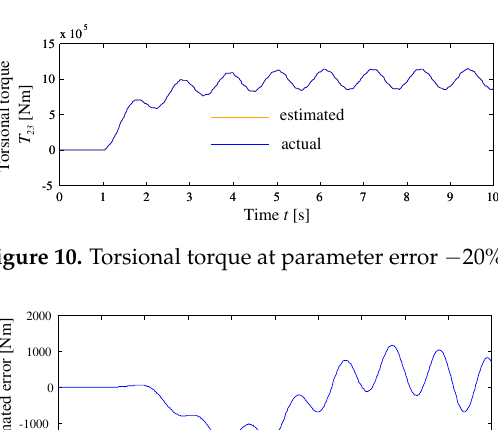
Figure 9. Estimated error at without parameter error.